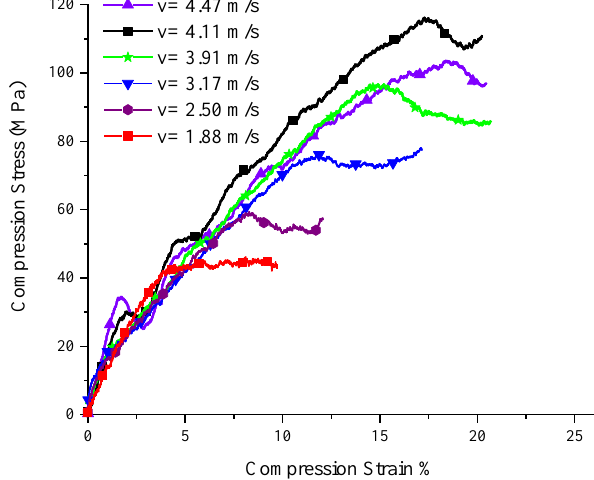
Figure 5. Force–displacement curve of 15° SCSs at different impact speeds.